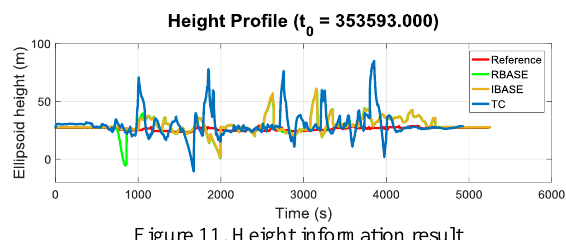
Figure 11. Height information result